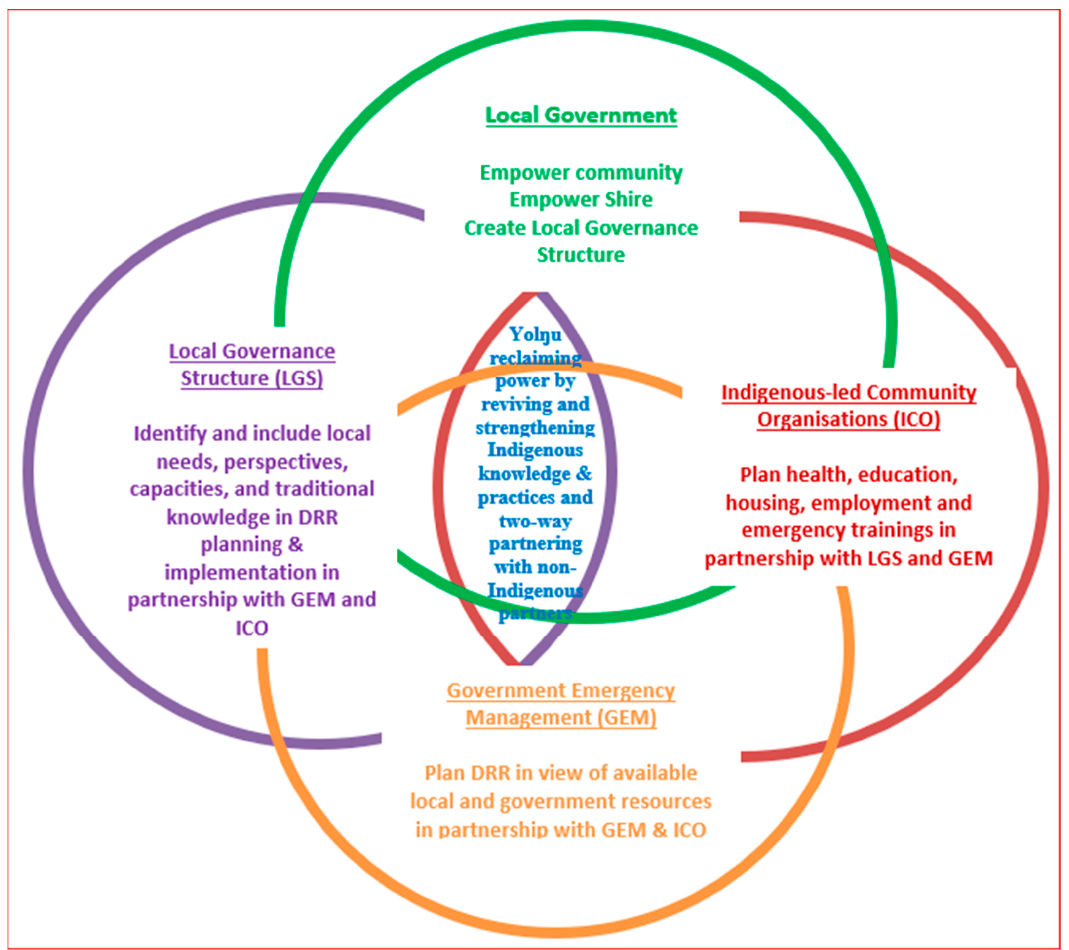
Figure 3. Indigenous two-way partnership Community-Based Disaster Risk Reduction (CBDRR)